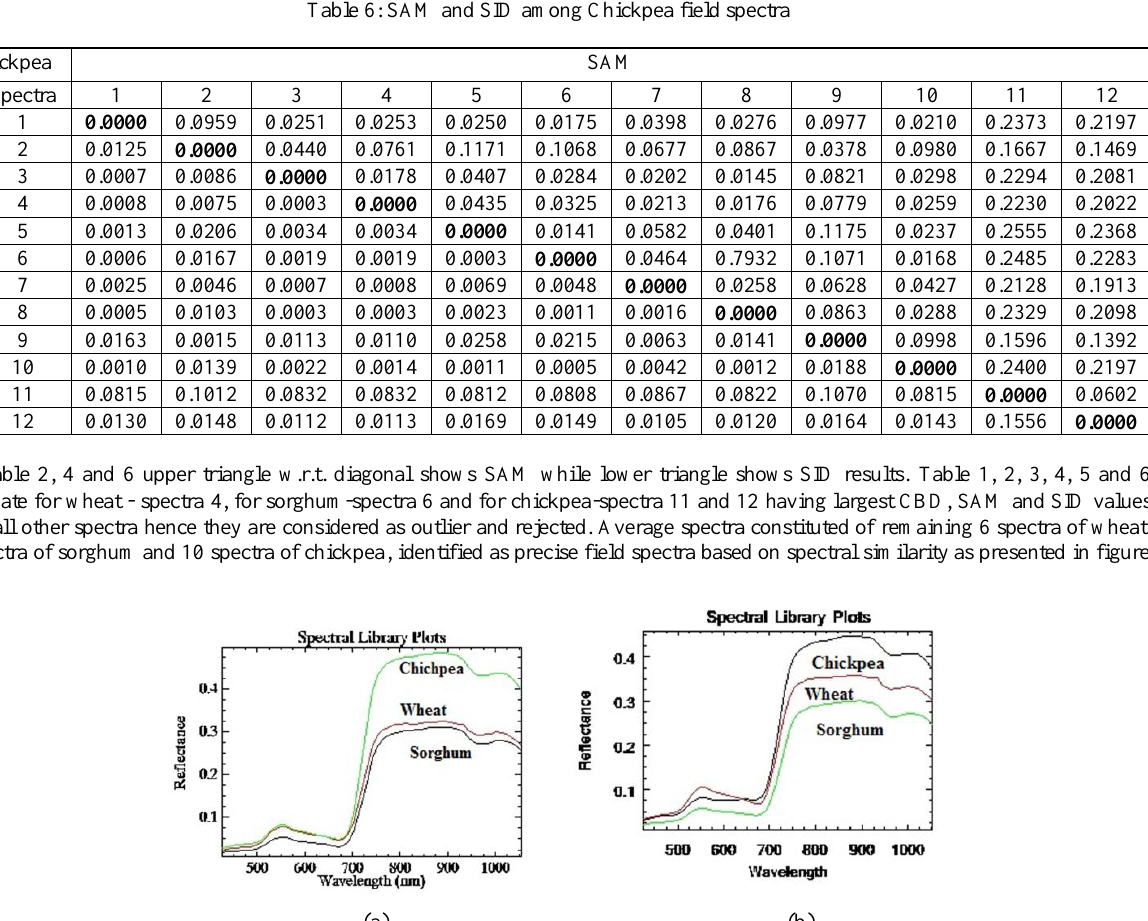
Table 6: SAM and SID among Chickpea field